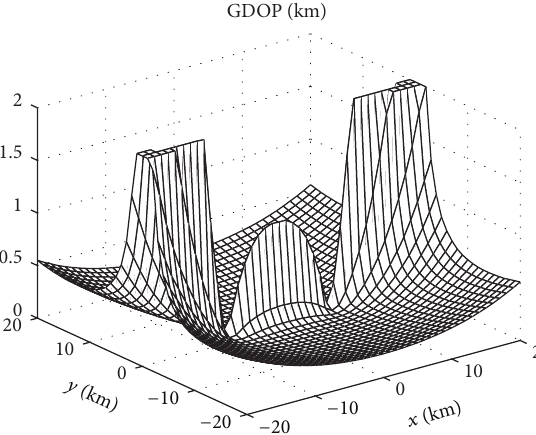
Figure 5: Distribution graph of three-dimensional